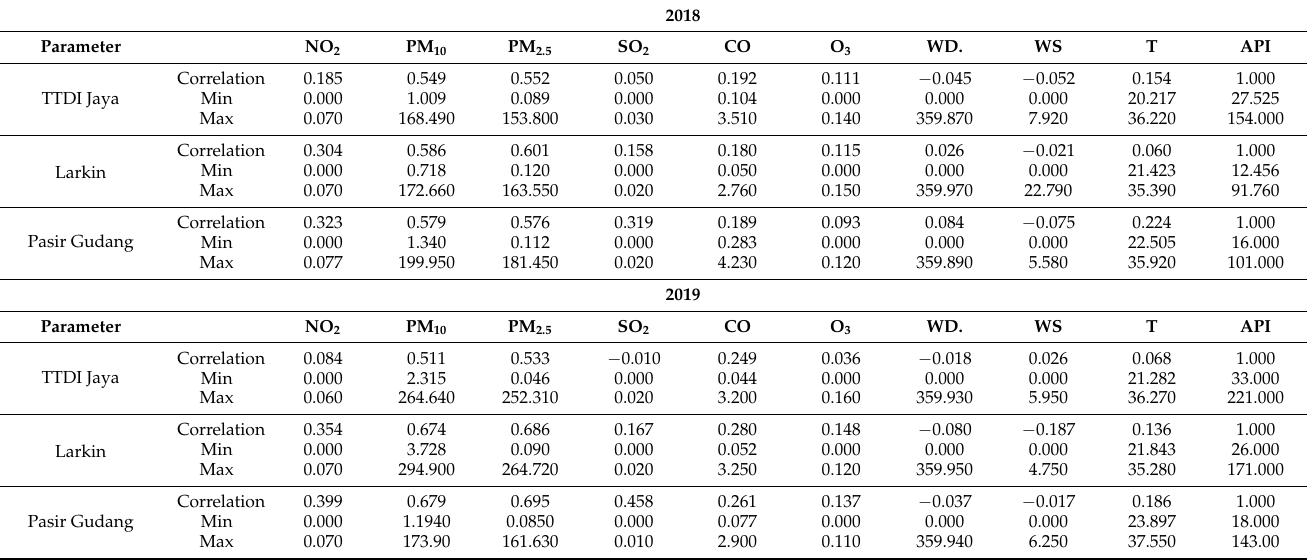
Table 1. Data range and correlation between the parameters and